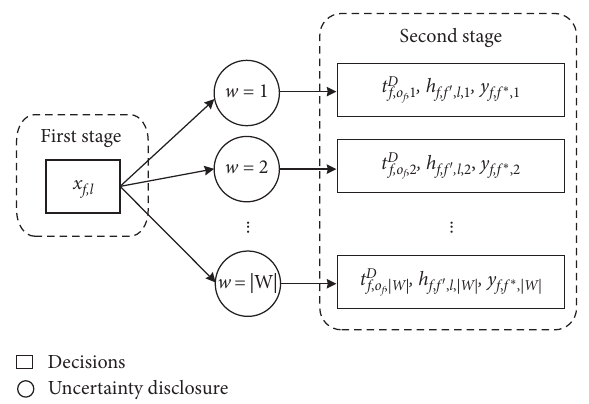
Figure 2: Representation of the two-stage decision-making